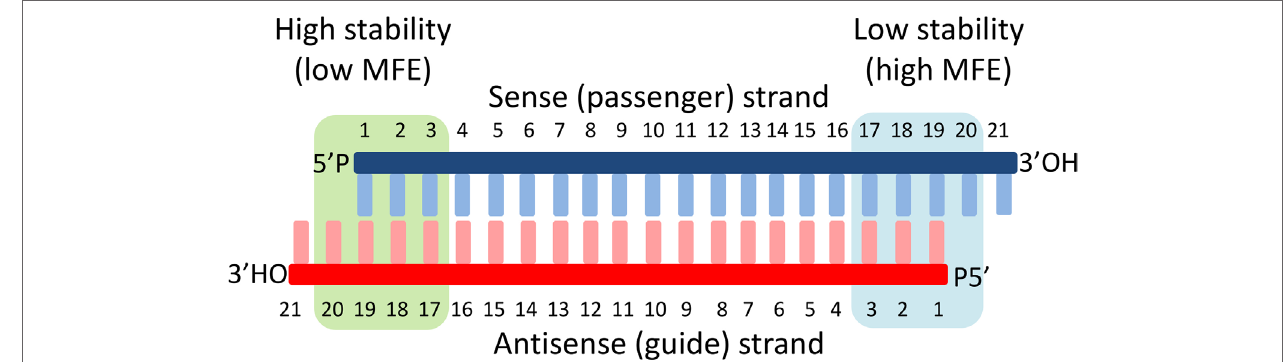
FIGURE 1 | Basic structure of siRNAs and the principles of strand selection. The siRNA is central to the RNA interference. They are usually produced by digestion of long double-stranded RNA fragments to small double-stranded fragments with specific lengths (~20 nucleotides) by RNAse III enzymes of Dicer type. Each fragment is then unwound by helicases into two single RNA strands, where only one of the strands (guide strand) is incorporated by an argonaute protein (AGO) into a RNA-induced silencing complex (RISC) and the other (passenger strand) is discarded. The discrimination mechanism for strand selection involves sensing of the thermodynamic stability of the 5’-ends of both strands and selection of those with lower 5’-end stability as a guide. In our approach, we calculate the minimum free energy (MFE) of both ends of the duplex, and the strand with the lower stability (high MFE) at its 5’-end is selected as a guide